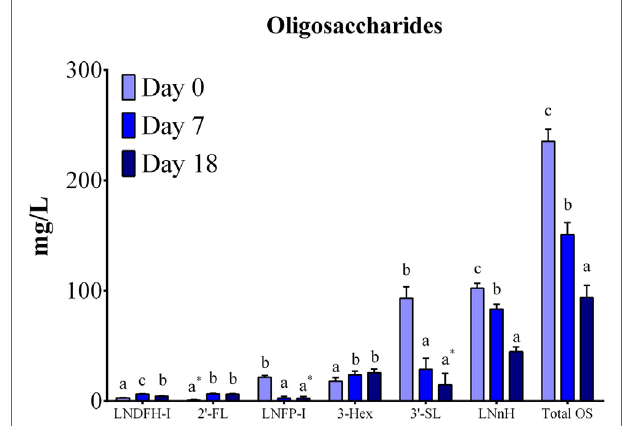
FigUre 2 | Oligosaccharide quantification by hPae-PaD (expressed as mg/l) in porcine milk . Total OS concentrations decreased ( P < 0.0001) across lactation. Individual differences were observed for six quantified OS, with all OS exhibiting changes in concentration ( P < 0.05) throughout lactation. The following OS had concentrations below detectable limits for the specified number of sows ( n ) for at least one analyzed time point: 2 ′ FL ( n = 4), LNFP-I ( n = 5), 3-Hex ( n = 1), 3-SL ( n = 1). Means with an * are not statistically different than 0. abc Indicate statistical differences among time of milk collection during the lactation period, where means that do not share a common superscript letter differ ( P < 0.05, HSD-Tukey Test). Abbreviations: LNDFH-I, lacto-N-difucohexaose I; 2 ′ -FL, 2 ′ -fucosyllactose; LNFP-I, lacto-N-fuctopentaose I; 3-Hex, α 1-3, β 1-4- d -galactotriose; 3 ′ -SL, 3 ′ -sialyllactose; LNnH, lacto-N-neohexaose.